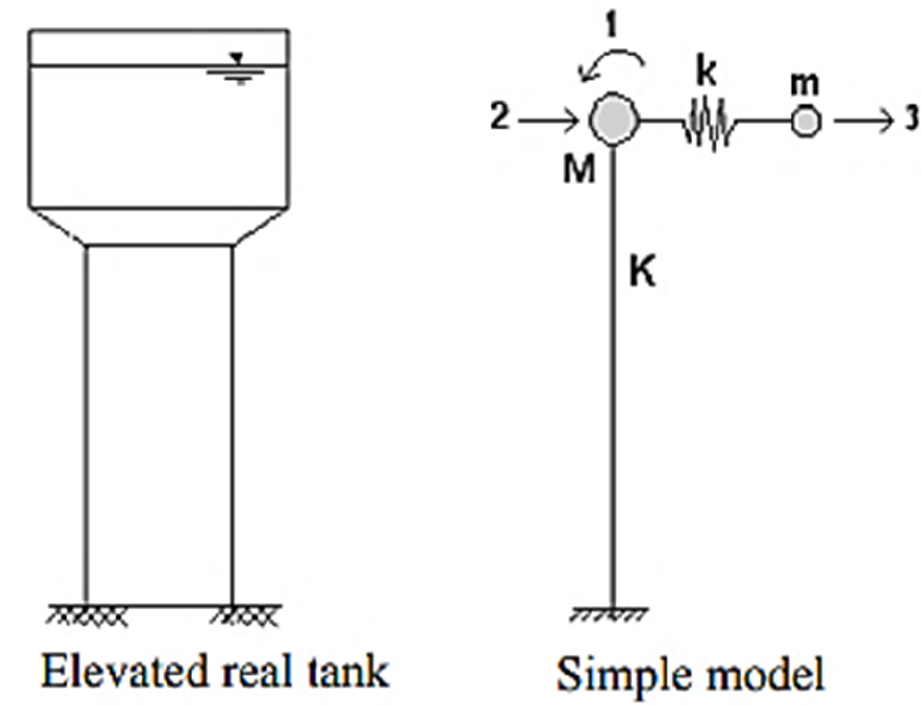
8 of 24 Figure 4. Time history of the vertical/horizontal ground acceleration (Koyna, 1967). ( a ) Horizontal